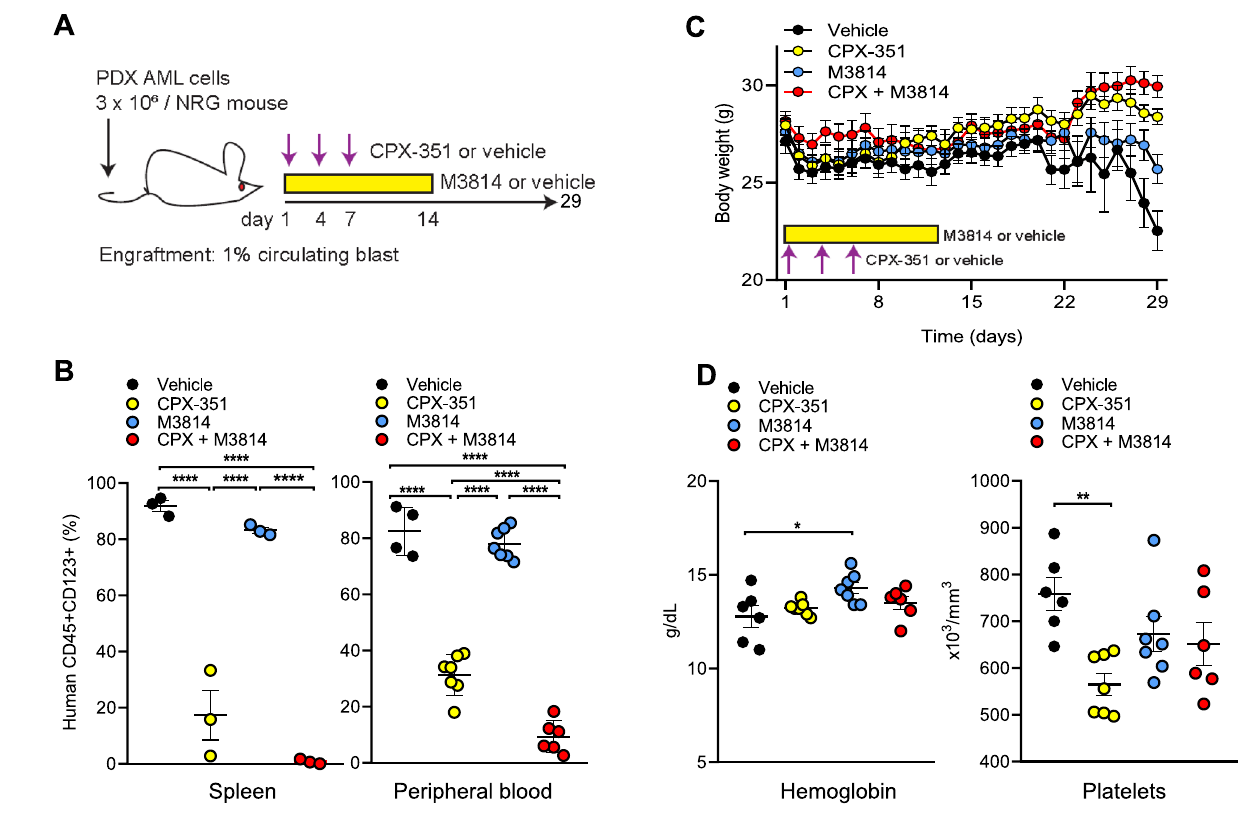
Figure 7. Combination treatment with CPX-351 and M3814 is tolerable and induces profound cytoreduction compared to CPX-351 alone in vivo. ( A ) In vivo treatment scheme. Mice were injected with 3 × 10 6 PDX AML cells and after engraftment (defined as > 1% circulating human CD45 and CD123 double positive cells) were randomly assigned to four groups (N = 10 each) and treated with vehicle, M3814 (oral gavages, 25 mg/kg twice a day for 14 days), CPX-351 (intravenous injections, 5 U/kg on days 1, 4 and 7) and M3814 + CPX-351. M3814 was formulated weekly in 0.5% Methocel A4M (Sigma 94,378), 0.25% Tween 20 and 300 mM sodium citrate. The leukemia burden was monitored as percentages of human CD45 and CD123 double positive cells in peripheral blood collected by retroorbital bleeding. After treatment for the indicated time, three mice from each group were randomly selected and euthanized by CO 2 asphyxiation and cervical dislocation on day 21, when mice in the vehicle-treated group became moribund. Percentages of human CD45 and CD123 double positive cells were measured by flow-cytometry. ( B ) Left: Percentages of human CD45 + CD123 + blasts in spleens for each treatment group on day 21. Right: Percentages of human CD45 + /CD123 + circulating blasts for each treatment group on day 28. Ordinary one-way ANOVA analysis was used for multiple comparisons. ( C ) Body weight during treatment courses for each group. ( D ) Hemoglobin and platelets levels for each treatment group on day